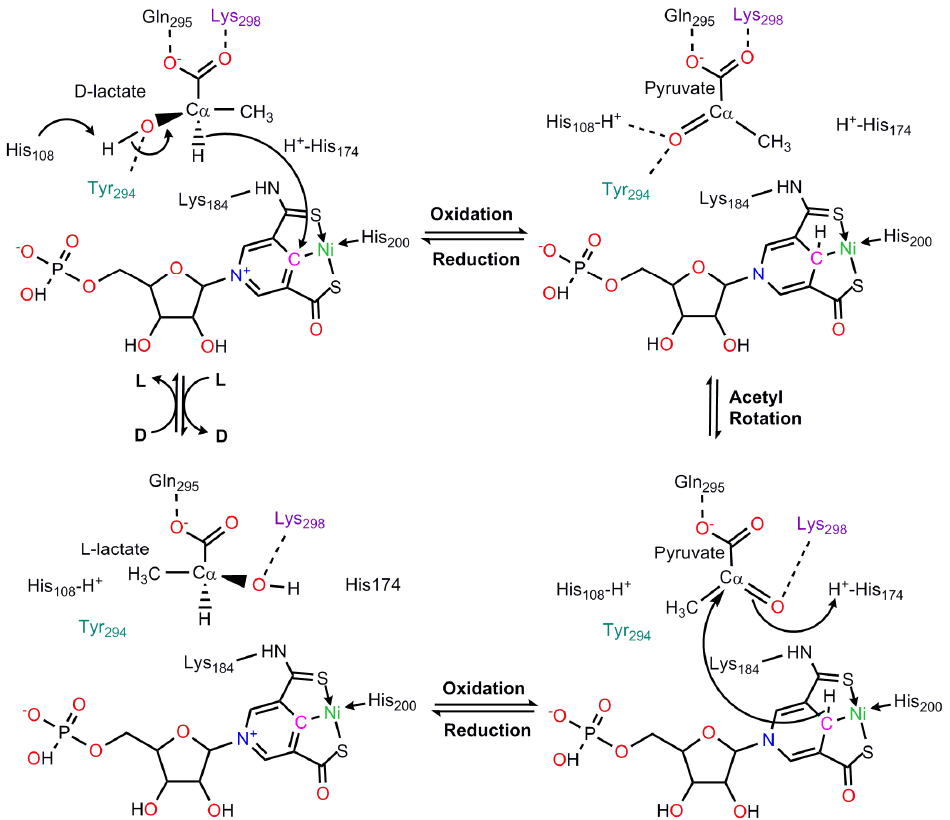
Figure 10. A modified proton-coupled hydride transfer mechanism for lactate racemase (LarA) proposed by Chen et al. Adapted from [129], copyright © WILEY-VCH Verlag GmbH & Co. KGaA, Weinheim. Tyr294 and Lys298 play crucial roles in orienting substrates and stabilizing the negative charge developing at the substrate hydroxyl oxygen in the transition states, thus lowering reaction barriers significantly.